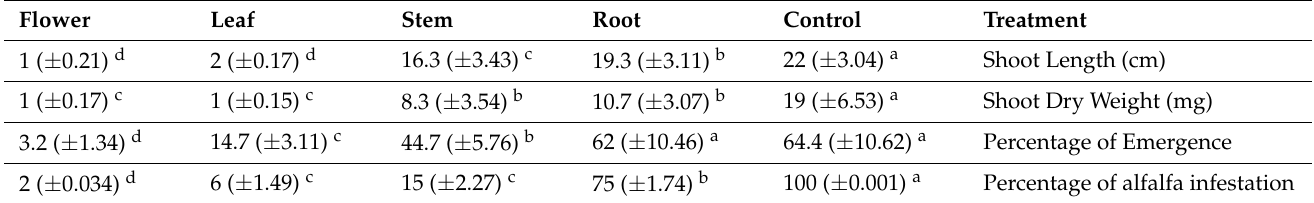
Table 2. Effect of extracts from different organs of N. meyeri on C. campestris seedling establishment and parasitation of alfalfa plants. Different letters indicate statistically significant differences cal- culated by independent ANOVA analyses (n = 3, p -value < 0.05) for each phenotype followed by multiple mean comparison using Duncan